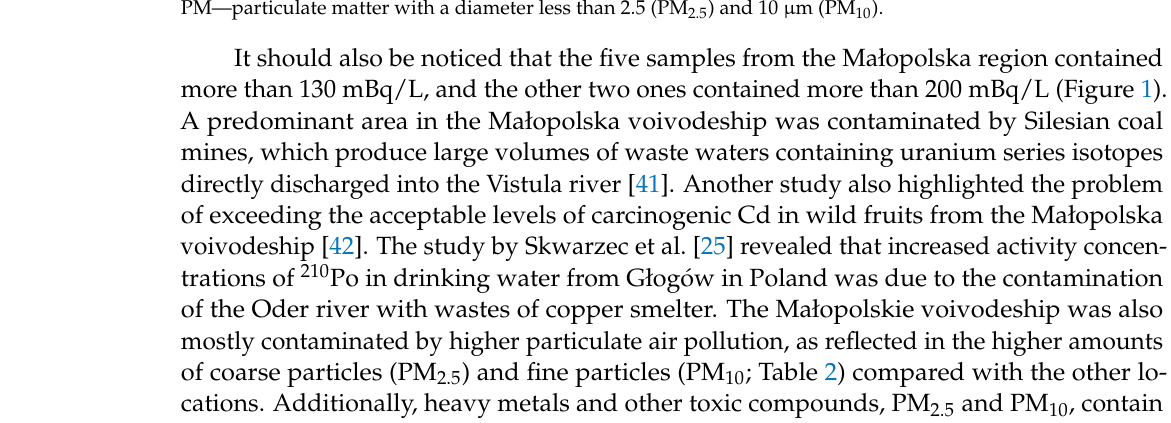
Table 2. Characteristics of production location of studied fruit wines.